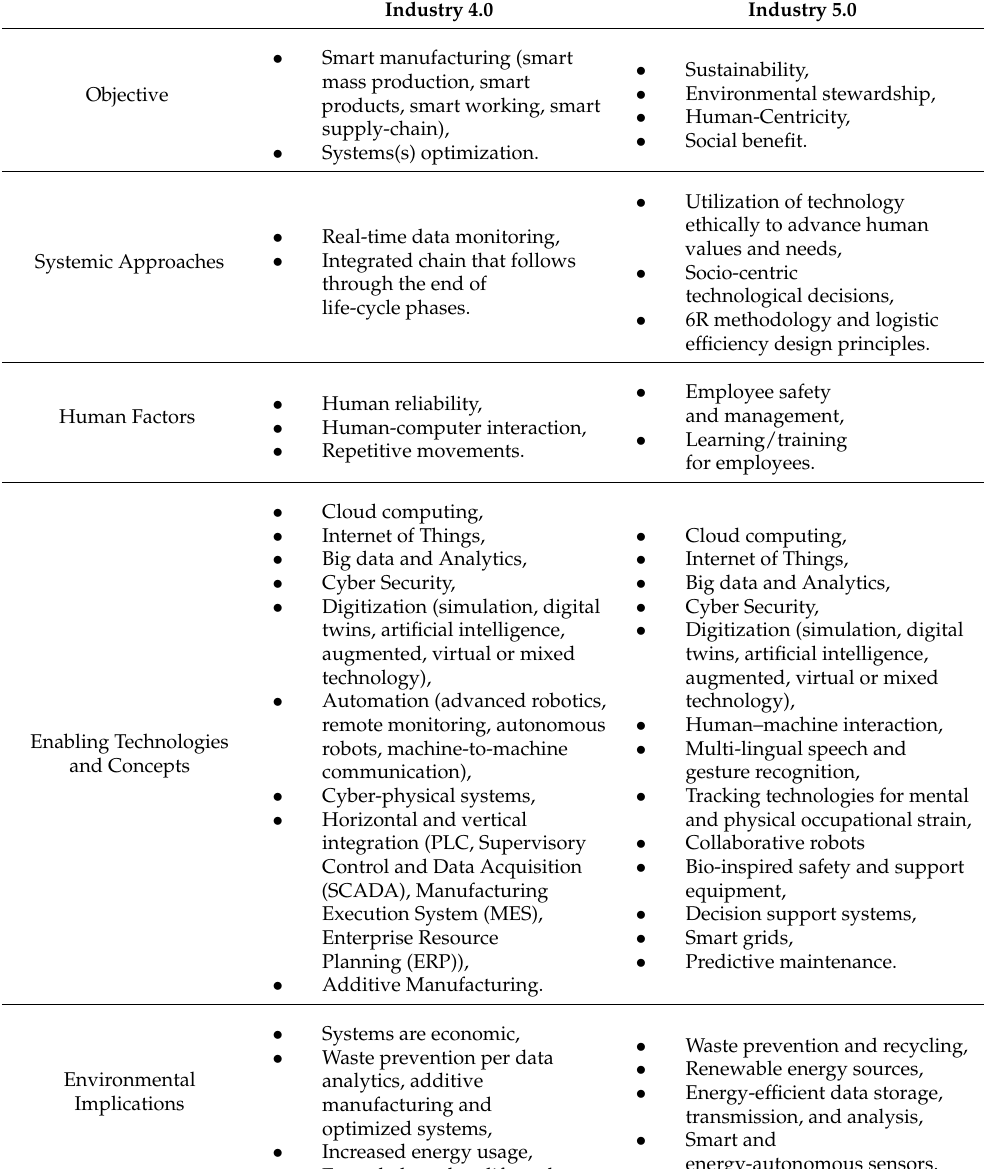
Table 1. Main differences between Industry 4.0 and 5.0 paradigms [40].